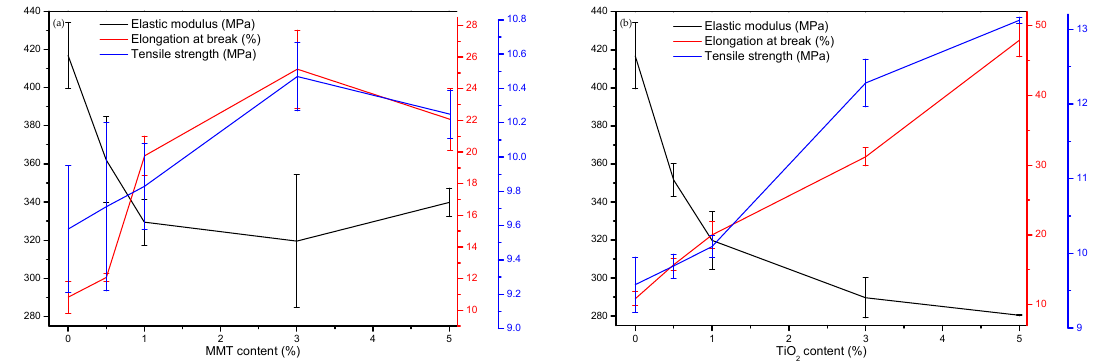
Figure 7. Tensile properties of ( a ) P-40-25 incorporated with MMT and ( b ) P-40-25 incorporated with TiO 2 .